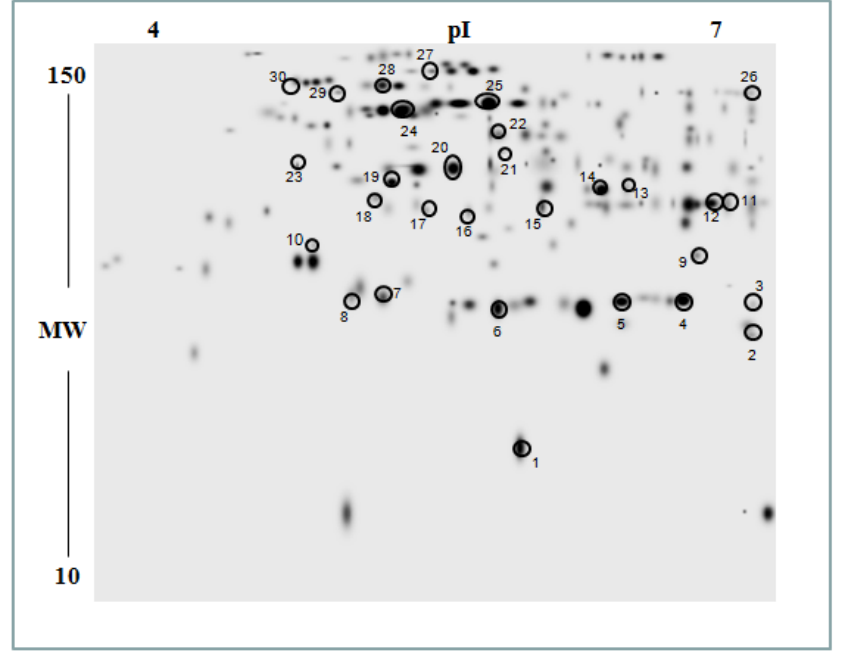
Figure 9. 2DE reference map of roots from control or osmotically stressed Svevo and Saragolla seedlings. Protein extracts from roots of control or treated with 18% PEG-6000 for 5 days, Svevo and Saragolla seedlings, were resolved on IPGs (first dimension) and 12% SDS-PAGE (second dimension) and were visualized by colloidal Coomassie blue staining. Gel images were analyzed for the detection, matching and quantification of protein spots, using PD Quest software. Spot numbering coincides with that reported in Table 2; experiments were carried out in triplicate for each biological sample.